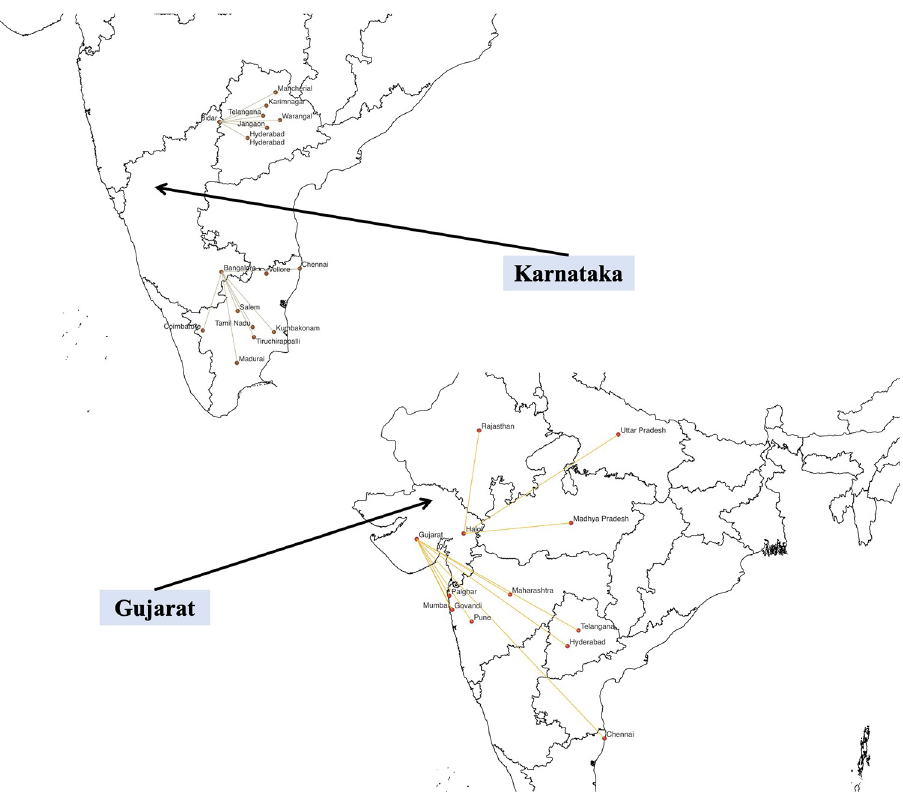
Fig 3. Illicit transport of gutka in Karnataka and Gujarat as reported in the media. State Boundaries Maps are provided by Data{Meet} Community Maps Project. It is made available under the Creative Commons Attribution 2.5